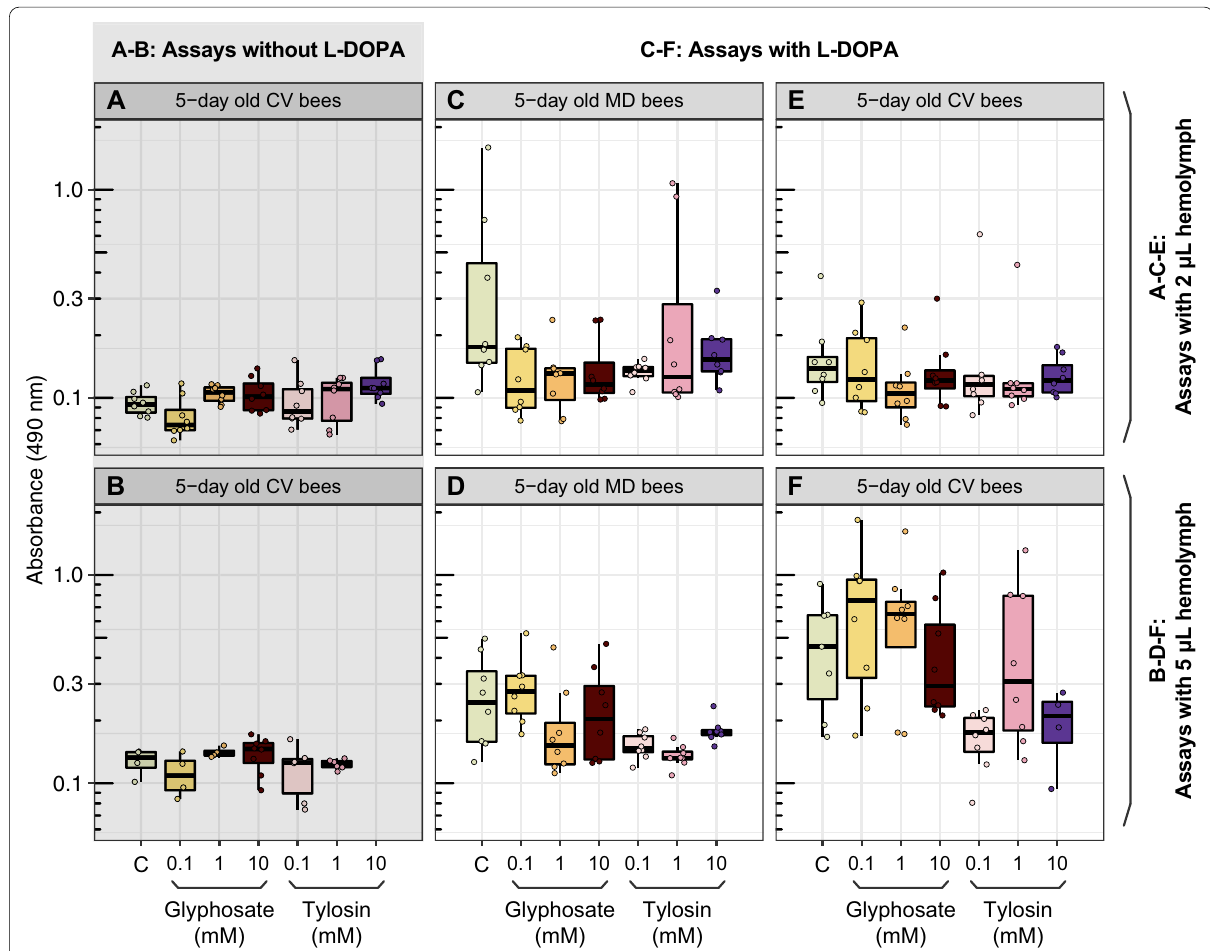
Fig. 7 In vivo experiments to investigate the effects of glyphosate or tylosin exposure on the melanization cascade in the hemolymph of honey bees. A – F Dopachrome formation was measured in the hemolymph of honey bees previously exposed to different concentrations of glyphosate or tylosin. A , B No l -DOPA was added to the assays. C – F l -DOPA was added to the assays. Samples were incubated for 30 min at 30 °C, and absorbance was measured at 490 nm. A , C , D , E n 8 samples per group. B n 4 samples for control, 0.1 mM glyphosate and 1 mM glyphosate groups; n = = samples for 10 mM glyphosate group,